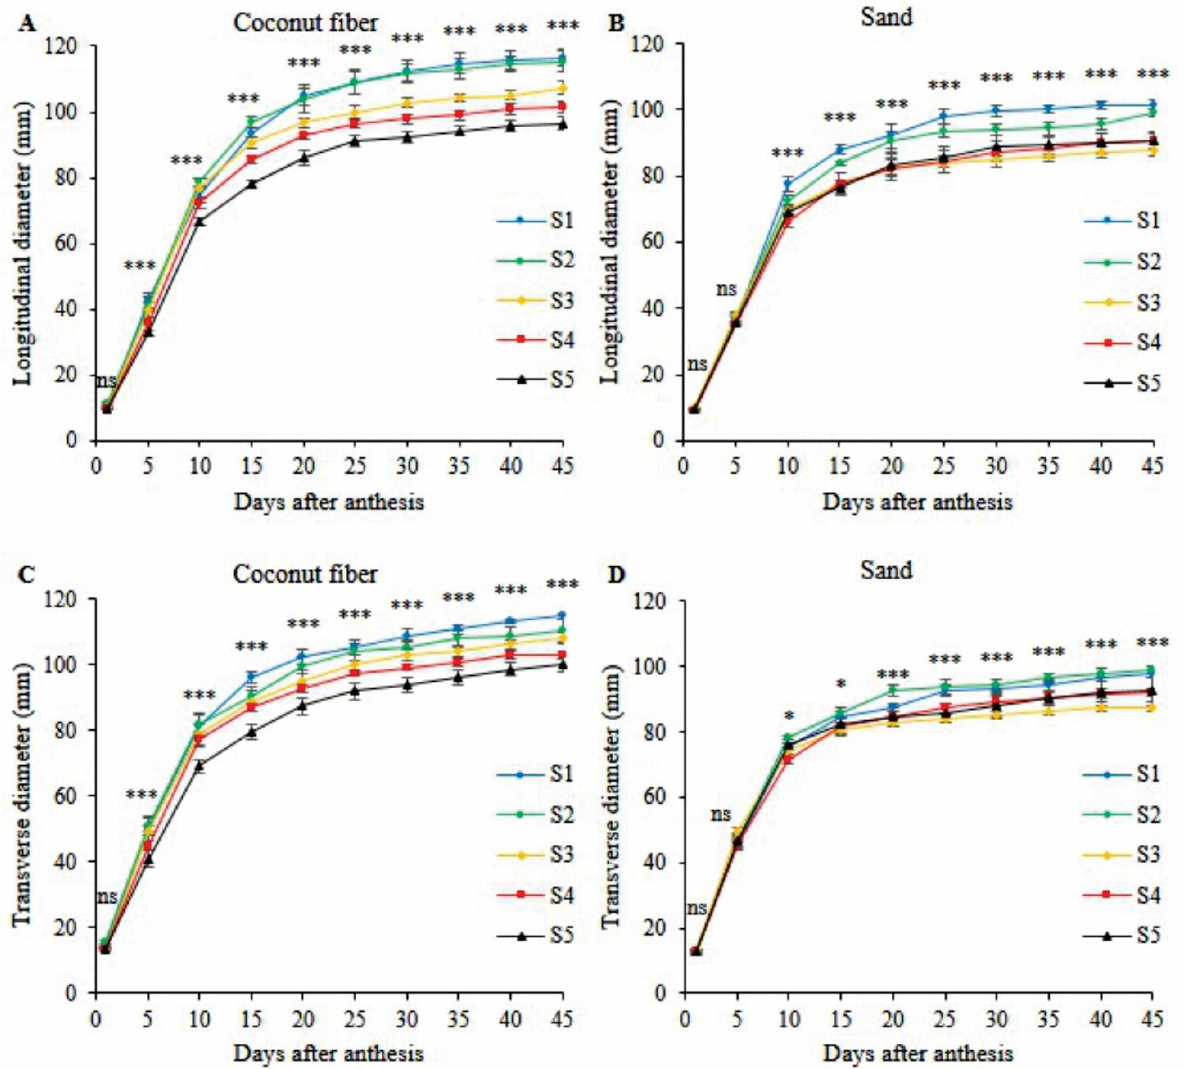
Figure 3. Means comparison test (Tukey, p < 0.05 and SD, n = 4) for longitudinal diameter ( A , B ) and transverse diameter ( C , D ) of mini watermelon fruits as a function of days after anthesis, in hydroponic cultivation using nutrient solution prepared with reject brine (S1—0.5 dS m − 1 , S2—2.4 dS m − 1 , S3—4.0 dS m − 1 , S4—5.5 dS m − 1 , S5—6.9 dS m − 1 ) and substrates (Coconut fiber and Sand). ***, * and ns significant at 0.001, 0.05 probability levels, and non-significant, respectively.